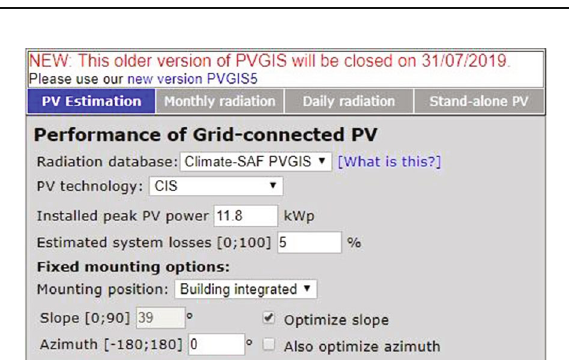
Figure 3: Visualization of solar panel design.